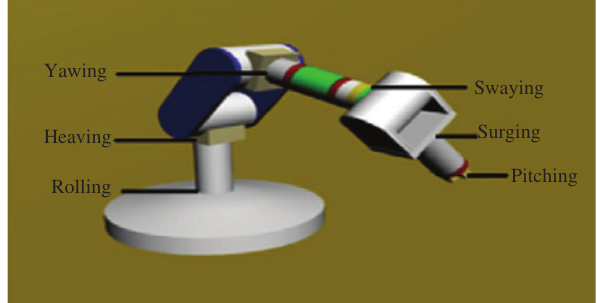
Figure 1: An Articulated Robot with Six dof in a Kinematic